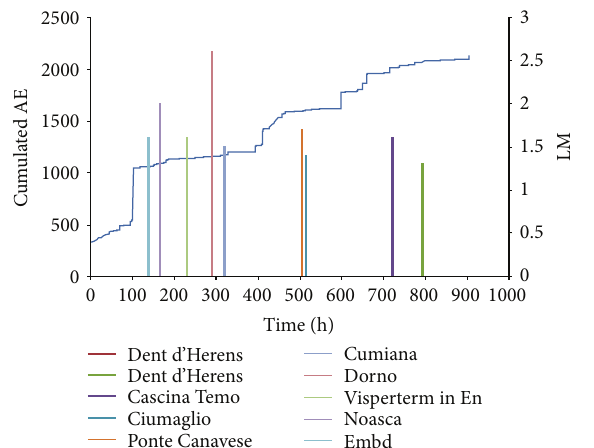
Figure 9: Sacred Mountain of Varallo: cumulated AE and seismic events from May 9, 2011 to June 16, 2011 (LM: local magnitude).